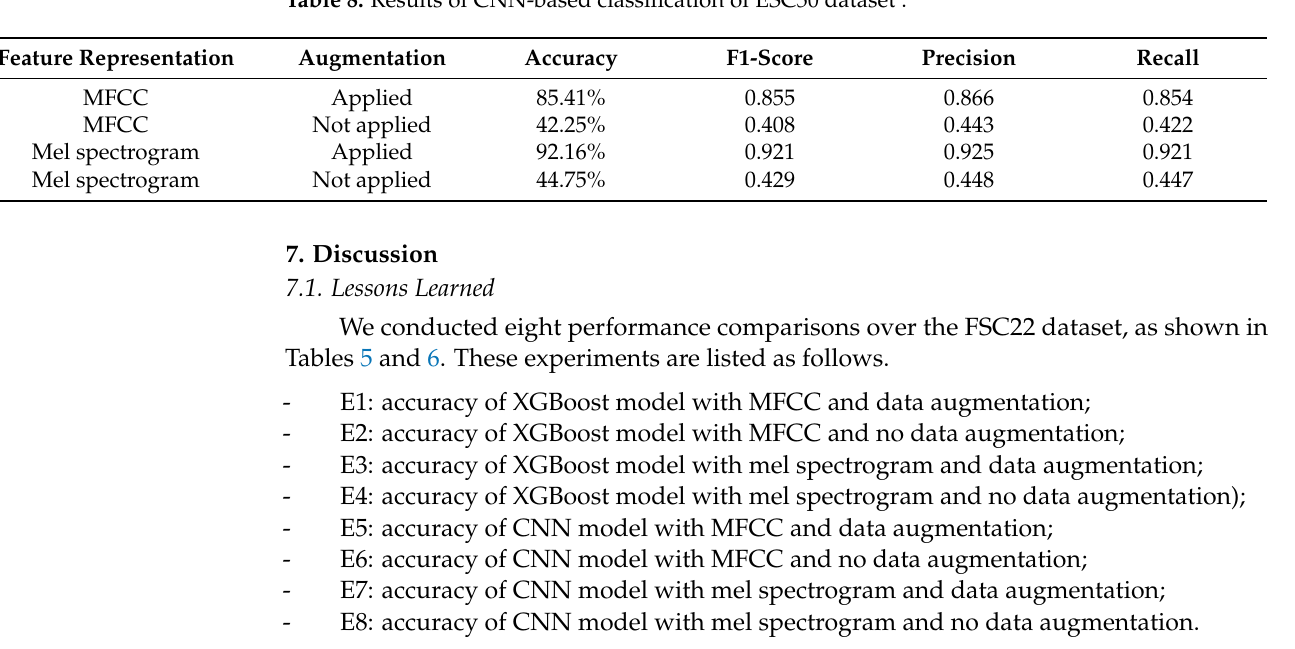
Table 8. Results of CNN-based classification of ESC50 dataset